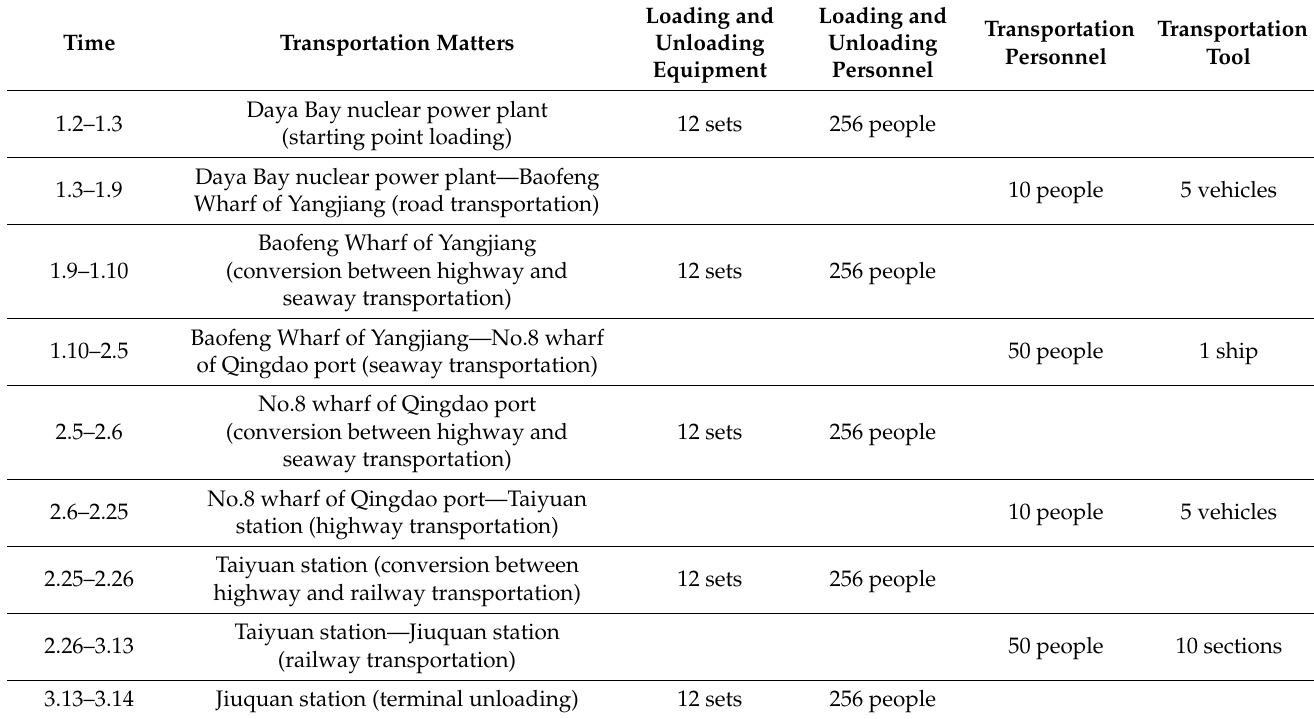
Table 4. Solution of the transportation